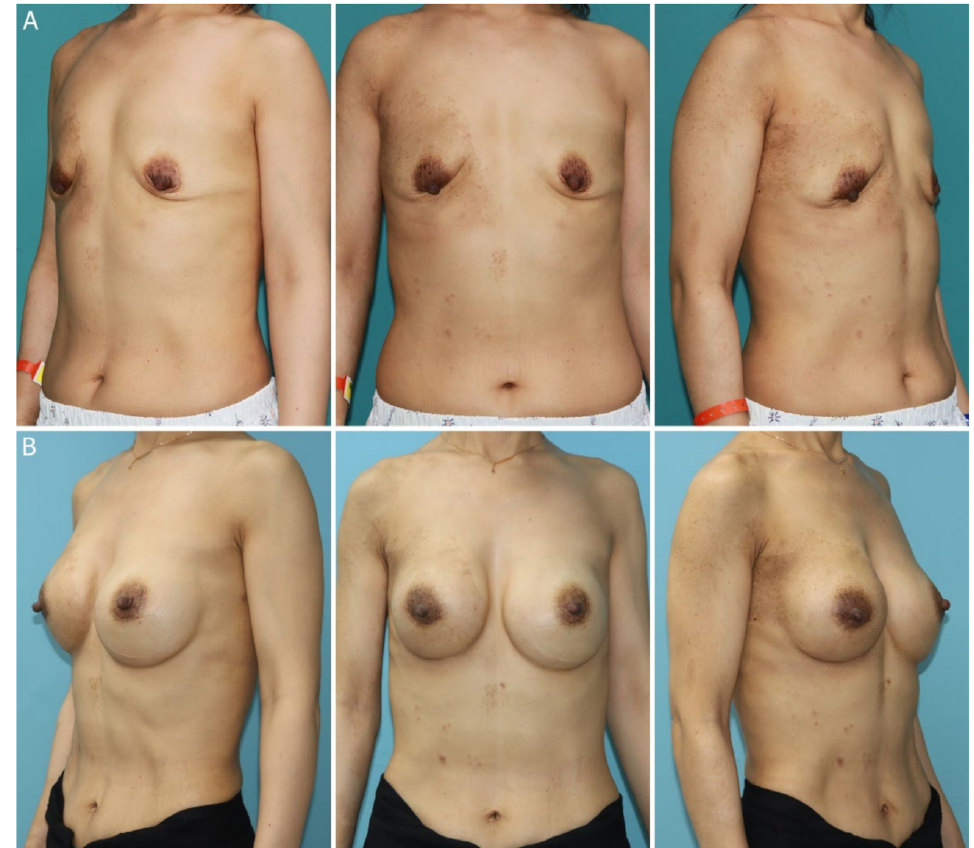
Figure 1. Pictures of the patient undergoing breast reconstruction following breast implant-associated anaplastic large cell lymphoma. ( A ) Left oblique view, anterior-posterior view, and right oblique of the patient prior to breast reconstruction. ( B ) Left oblique view, anterior-posterior view, and right oblique view of the patient 11 months post